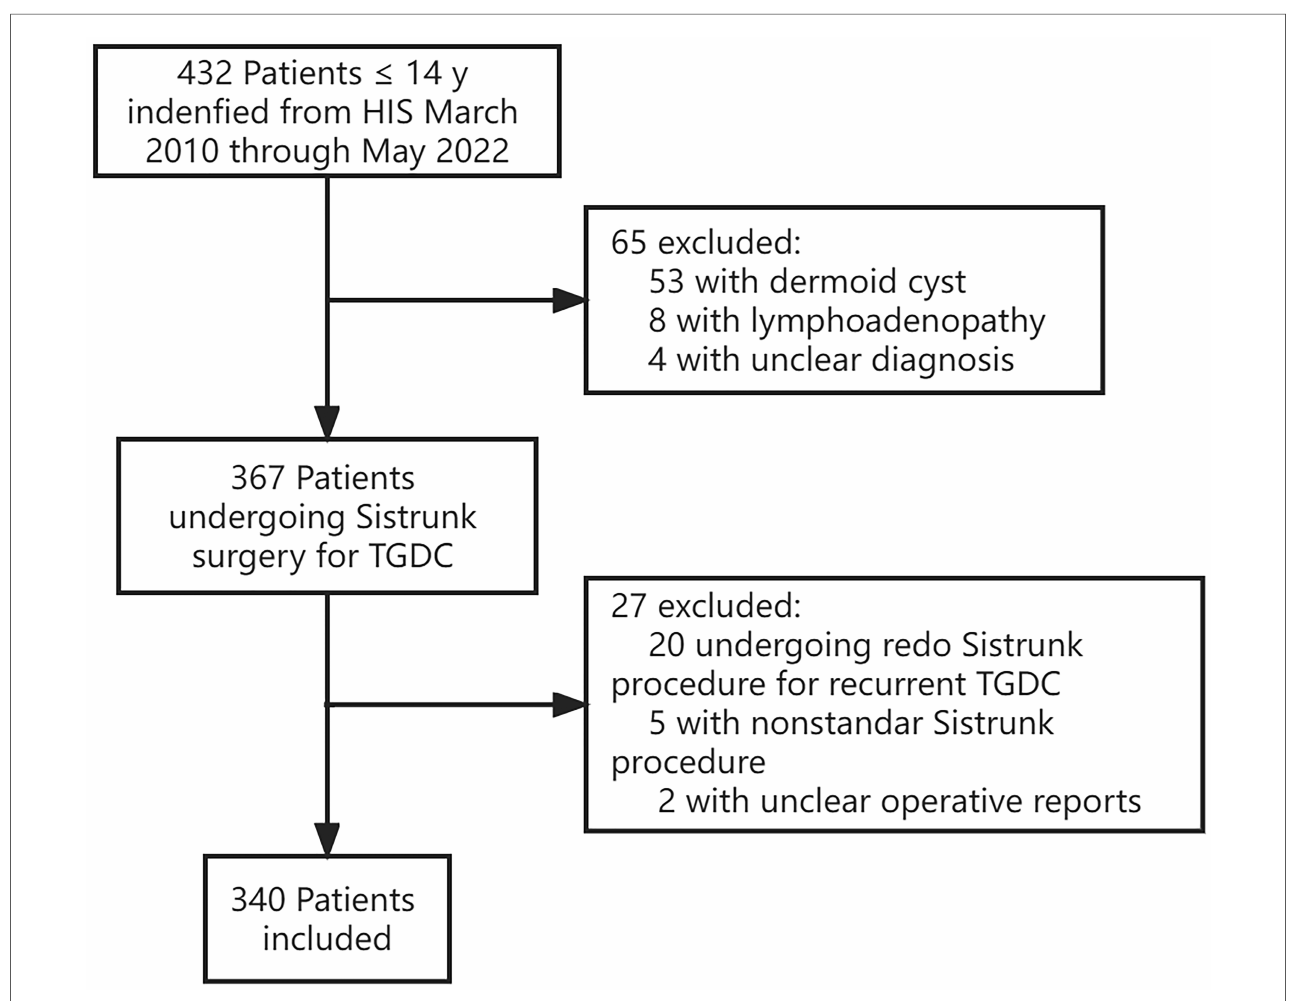
FIGURE 1 STROBE fl ow chart for selection of patients in the study. HIS, hospital information system; TGDC, thyroglossal duct